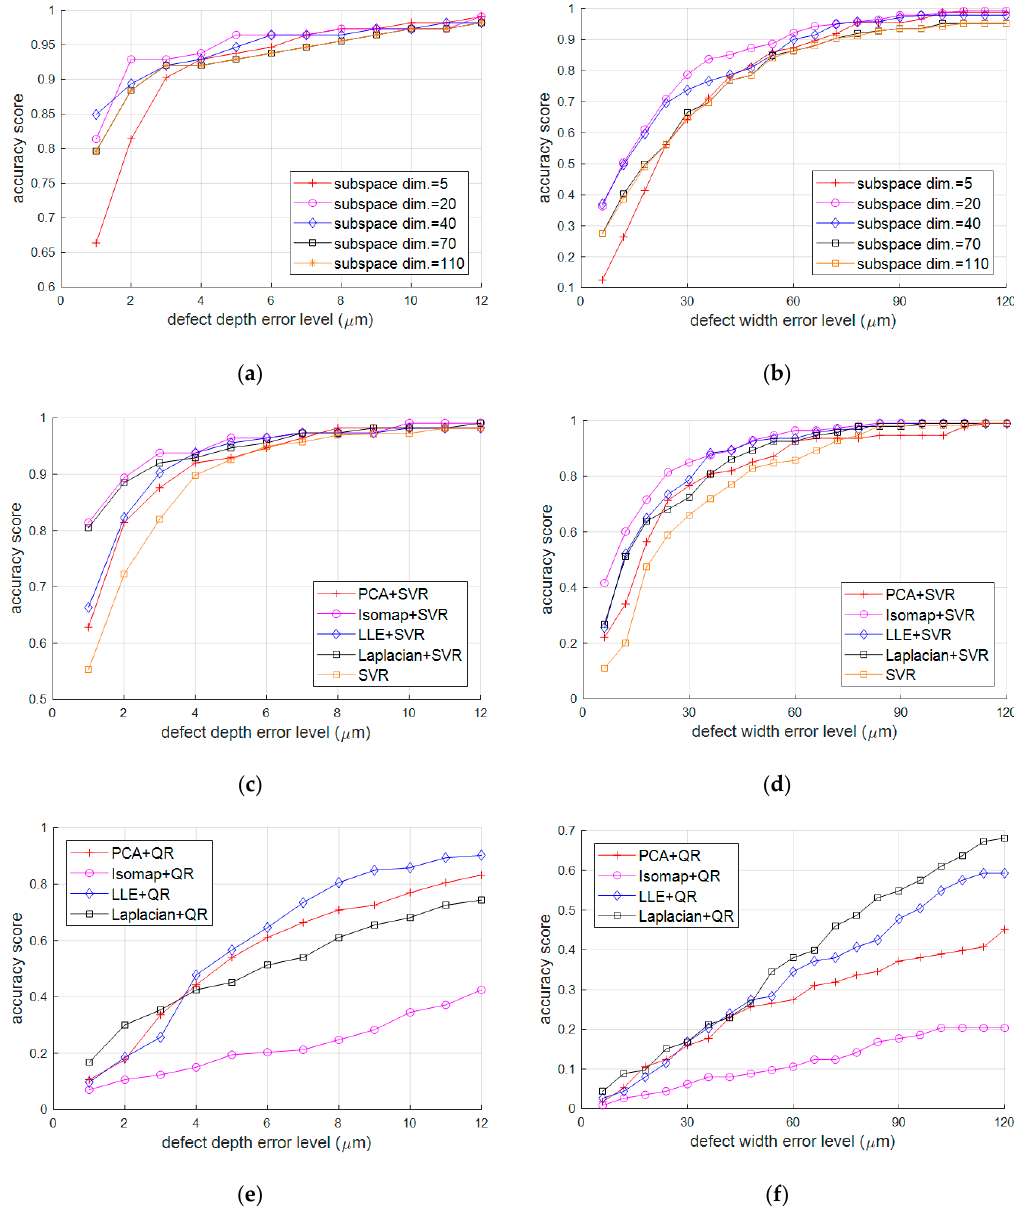
Figure 12. Comparison curve of cumulative accuracy score versus error level. ( a ) Depth estimation using isometric mapping (ISOMAP) + support vector regression (SVR) with different subspace dimensions, ( b ) width estimation using ISOMAP + SVR with different subspace dimensions, ( c ) depth estimation using SVR with 20 subspace dimensions, ( d ) width estimation using SVR with 20 subspace dimensions, ( e ) depth estimation using quadratic regression (QR) with 20 subspace dimensions, ( f ) width estimation using QR with 20 subspace dimensions.